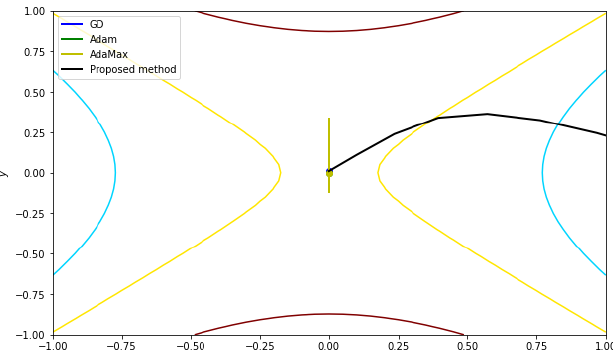
Figure 11. The result of the saddle point with an initial point of (0, 0.01).